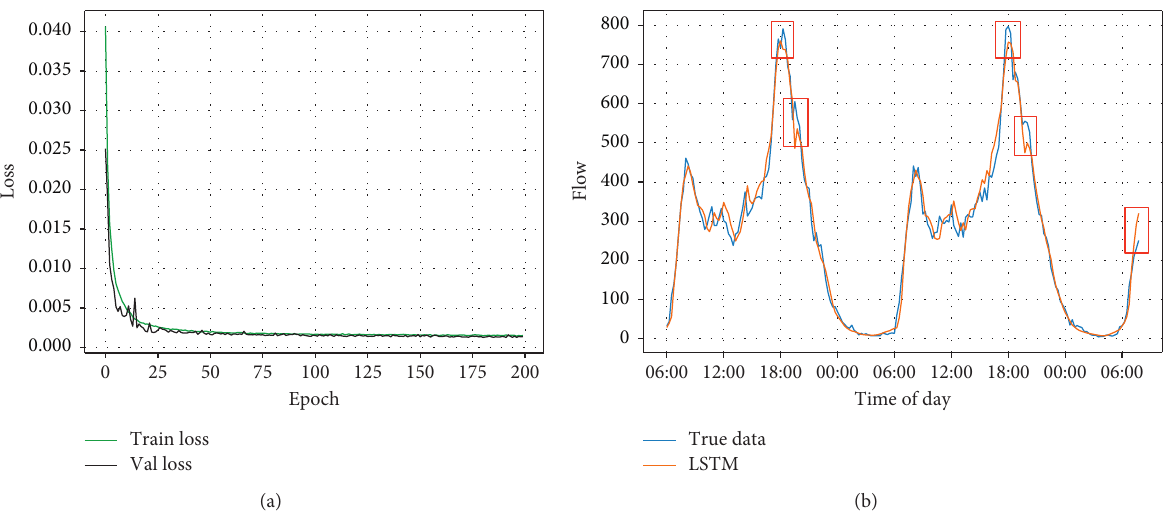
Figure 4: 15min LSTM training and prediction. (a)15min LSTM loss function and (b) 15min LSTM prediction results.